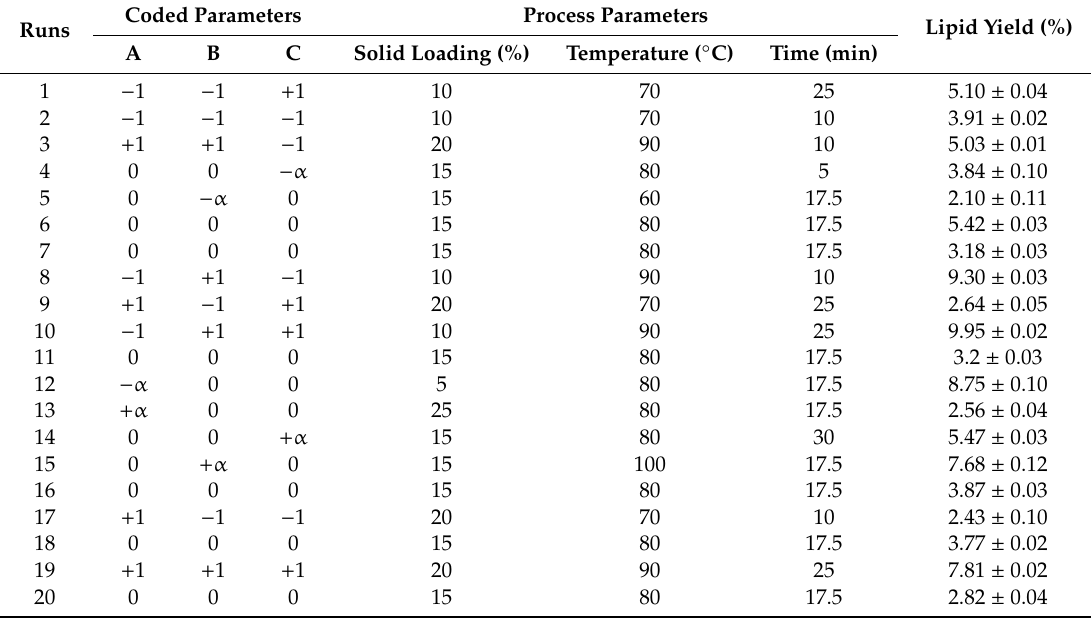
Table 4. The matrix of Central Composite Design (CCD) with experimental lipid yield values of MAE. Coded Parameters Process Runs